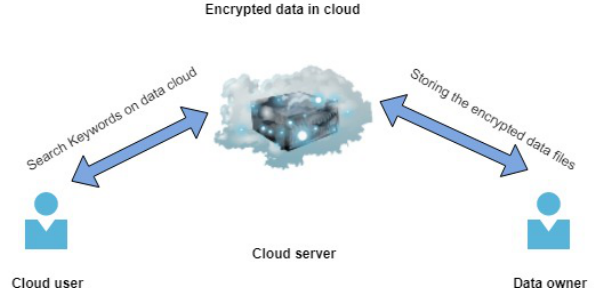
Figure 2. Encrypted data system of